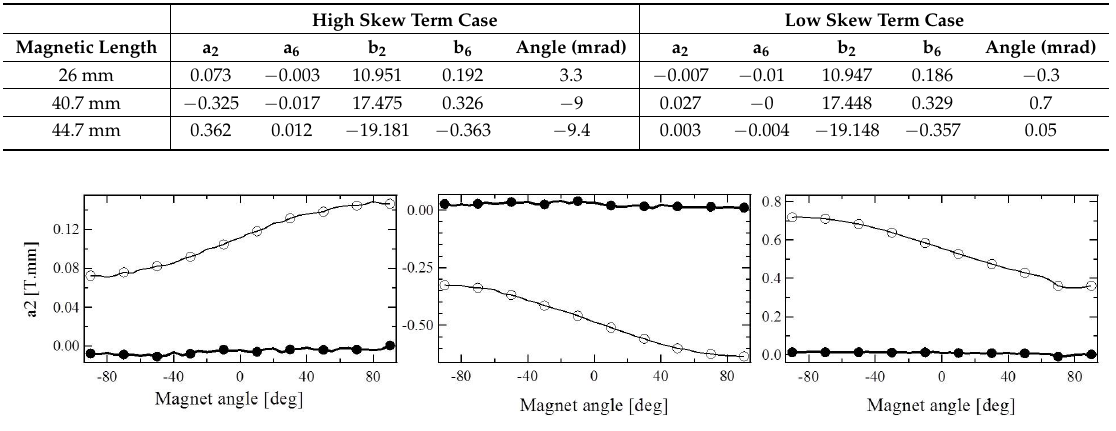
Figure 4. Skew quadrupolar term ( a 2 ) measured with the stretched wire, before ( ◦ ) and after ( • ) correction, for the QUAPEVA triplet: 26 mm ( left ), 40.7 mm ( middle ), and 44.7 mm ( right ), r 0 = 4